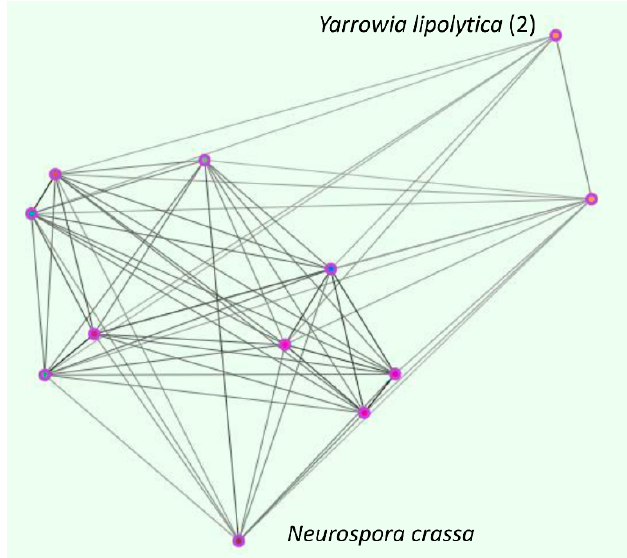
Figure 2. The fungal zincophore locus cluster (OG5_141027). Clustering performed using OrthoMCL. Orthologues of the zincophore-associated ZIP, Zrt1 (zinc regulated transporter 1) in C. albicans are specific to the fungal kingdom.